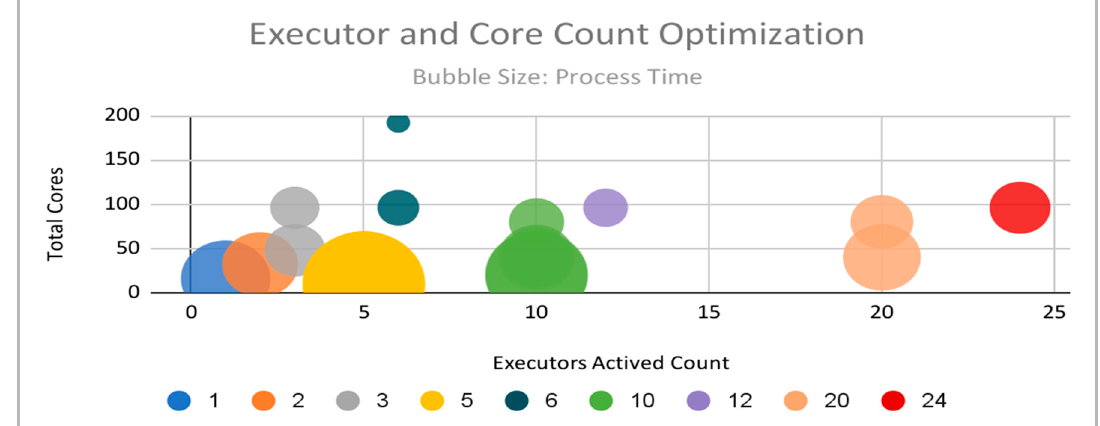
Figure 8. Processing times by number of executors and total number of cores across all executors.